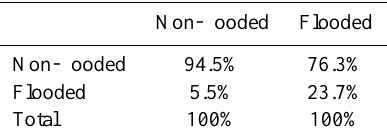
Table 4. Same as Table 3, but considering forested areas only.